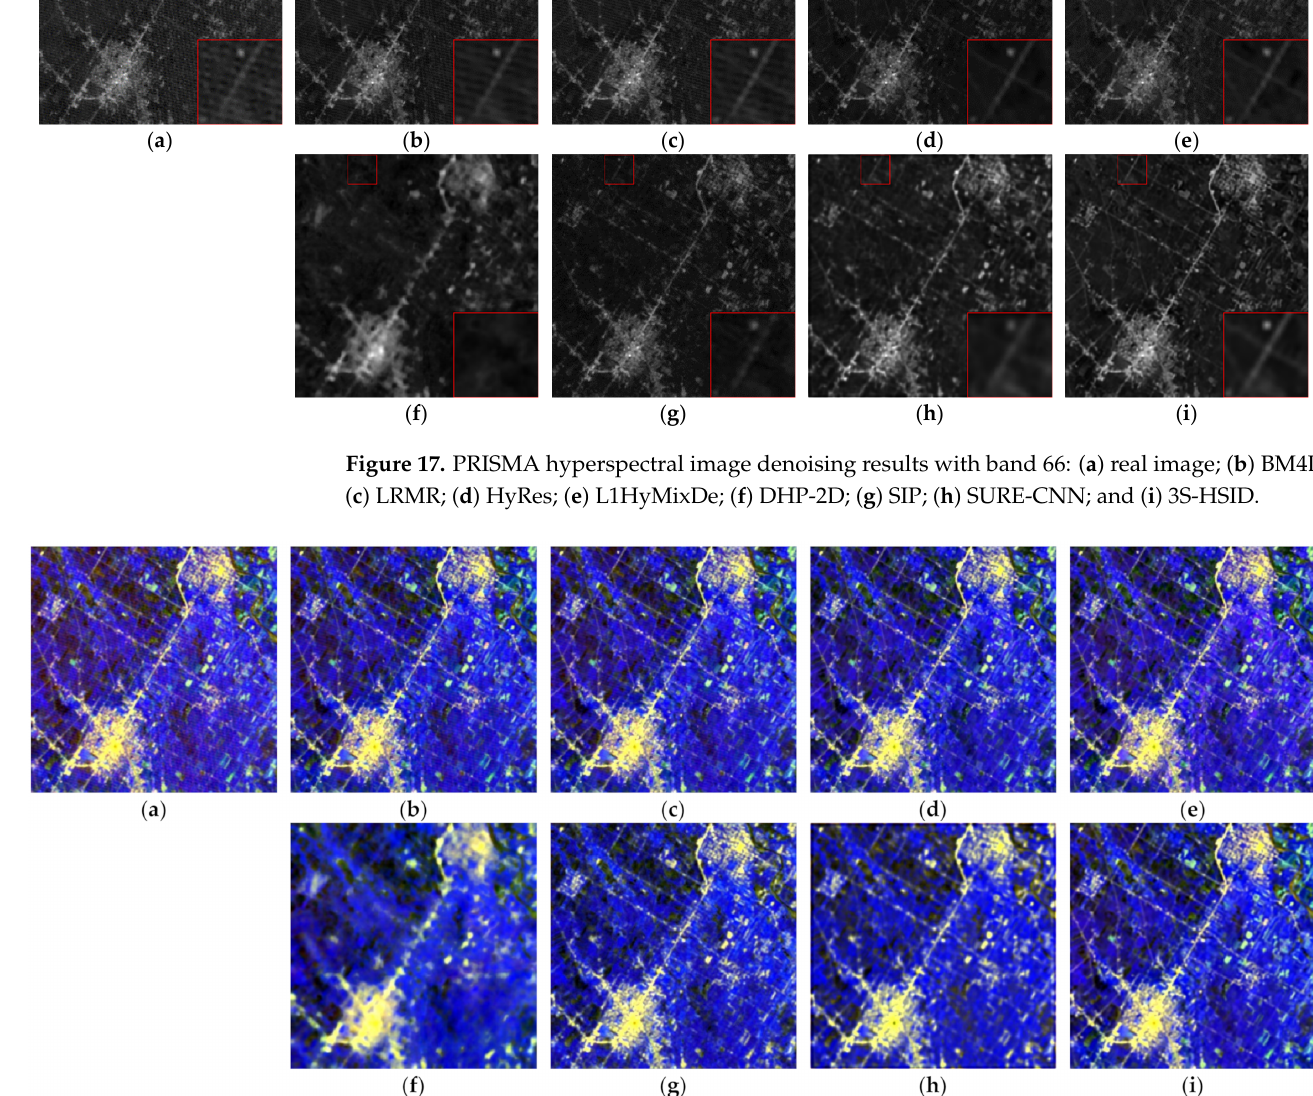
Figure 18. PRISMA hyperspectral image denoising results with false-color image (R: band 66, G: band 40, B: band 1): ( a ) real image; ( b ) BM4D; ( c ) LRMR; ( d ) HyRes; ( e ) L1HyMixDe; ( f ) DHP-2D; ( g ) SIP; ( h ) SURE-CNN; and ( i ) 3S-HSID.